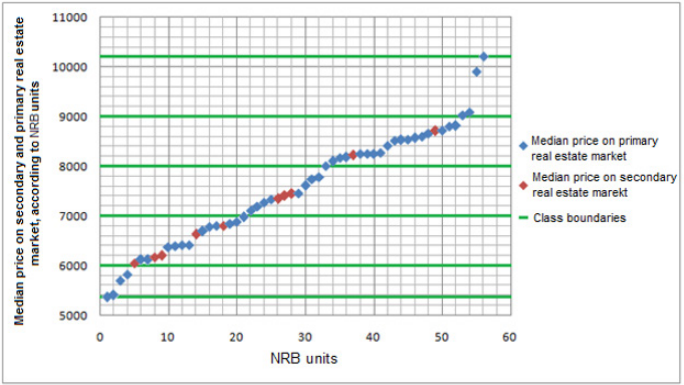
Fig. 3. Median transaction prices of residential premises in złotys per square metre on the primary and secondary markets, according to NRB units (source: own elaboration)